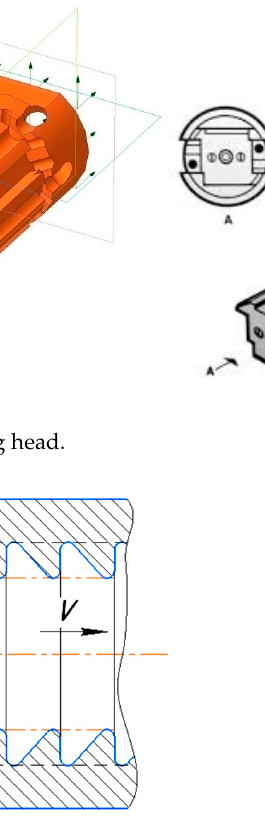
Figure 10. Developed laser spraying head: 1—end cap, 2—laser head housing, 3—tilt angle motor, 4—adjusting slider, 5—toothed hinge, 6—mirror, 7—hinge, 8—nozzle housing, 9—pressure hood,